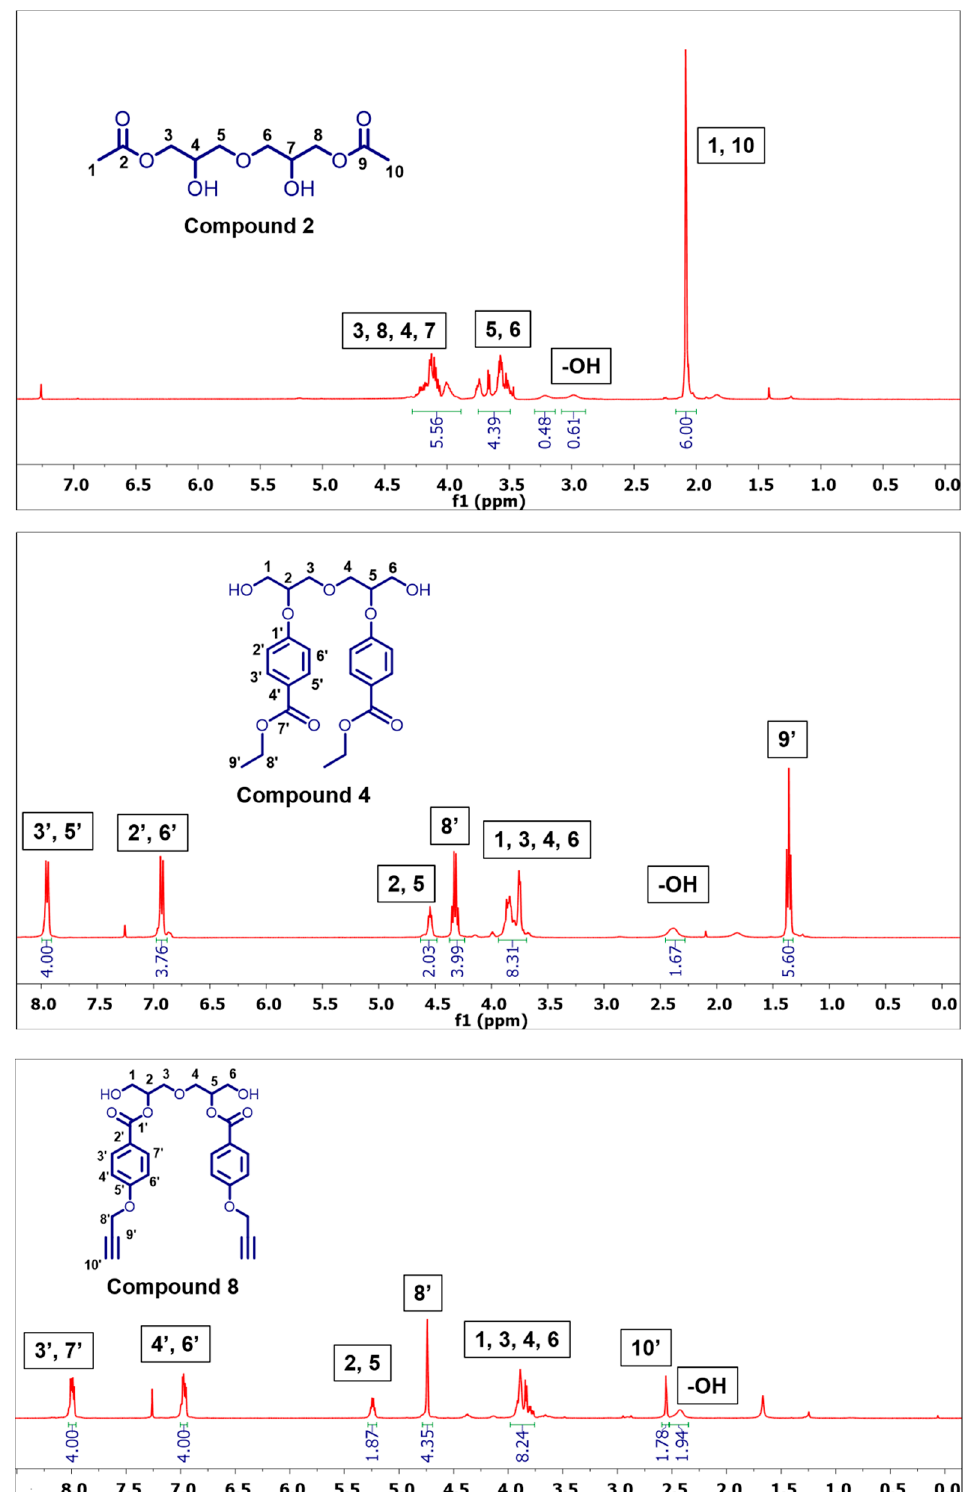
Figure 1. 1 H-NMR spectrum of compound 2 , 4 , and 8 .